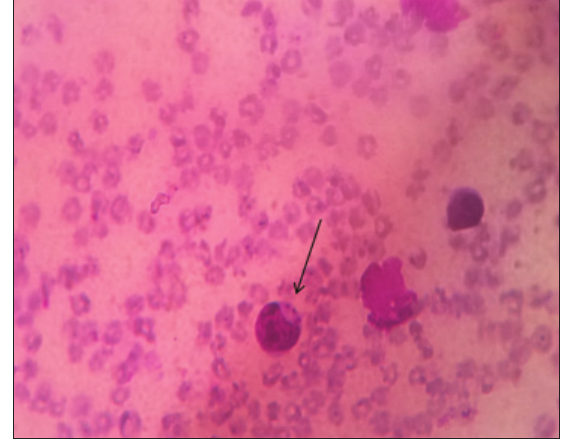
Figure-3: Koch’s blue bodies (macroschizont stage) in lymphocyte in Giemsa stained lymph node biopsy